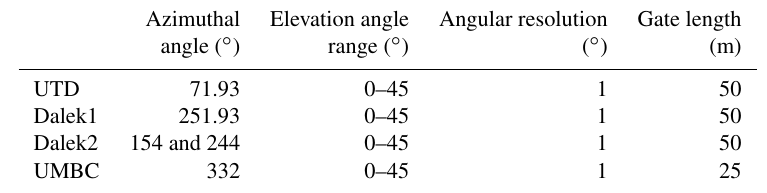
Table 3. Parameters of the different scanning lidars for the triple RHI scans.